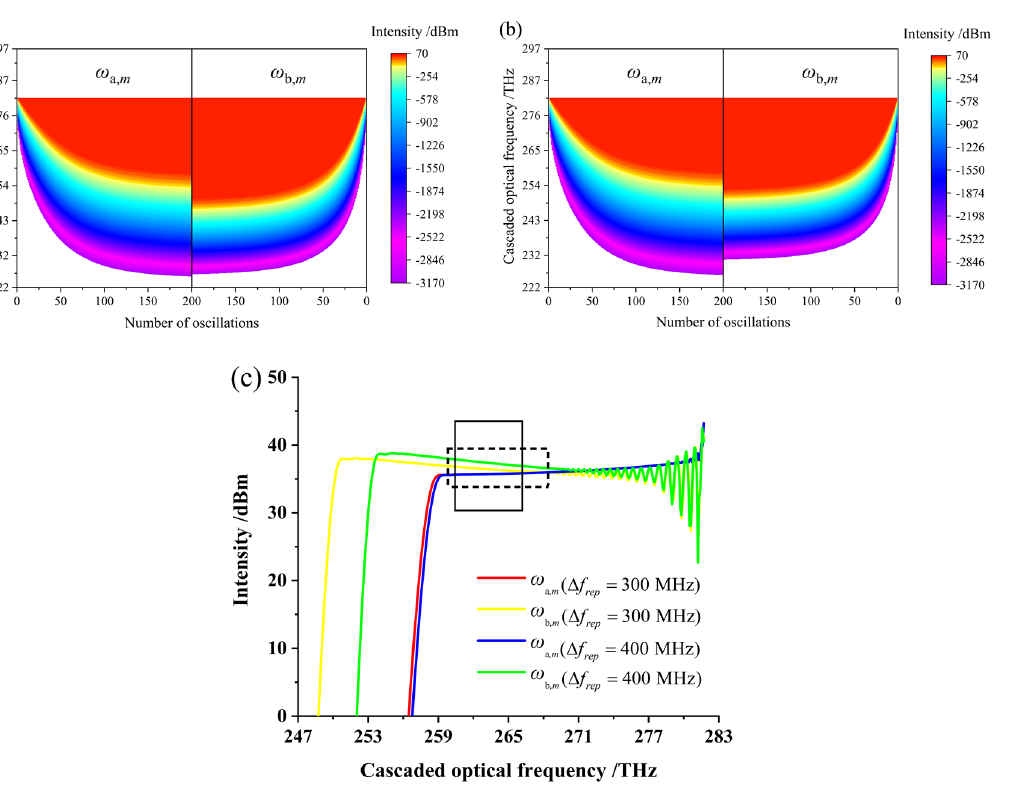
Figure 5. Evolution process of DOFC generated by DCDFG within the OPO. m = 200, L = 6 cm, I 0 = 100 MW/cm 2 , I 1 = 1 MW/cm 2 , I 2 = 1 MW/cm 2 ; ω 0 and ω a,1 are 281.9 THz and 281.8 THz, respectively. ( a ) Evolution of DOFC generated by DCDFG within the OPO with oscillation number N ; ω b,1 = 281.7997 THz, Δ f rep = 300 MHz. ( b ) Evolution of DOFC generated by DCDFG within the OPO with oscillation number N ; ω b,1 = 281.7996 THz, Δ f rep = 400 MHz. ( c ) Spectral distribution of DOFC with N = 200; the dashed box indicates Δ f rep = 300 MHz within 1 dB flatness, and the solid box indicates Δ f rep = 400 MHz within 1 dB flatness.